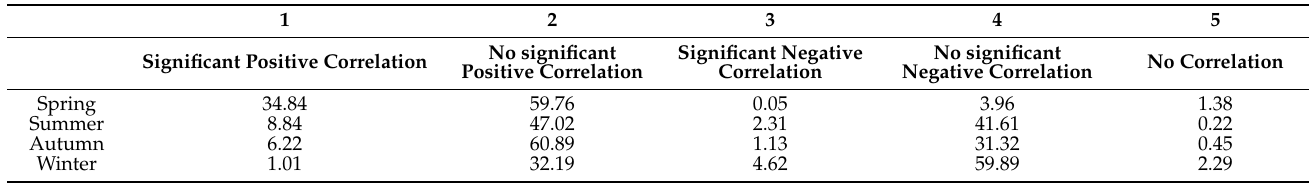
Figure 14. Spatial distribution of the correlation between seasonal FVC and PRE in the QBM from 2000–2020. Table 12. Area proportion of correlation level between FVC and PRE /%.